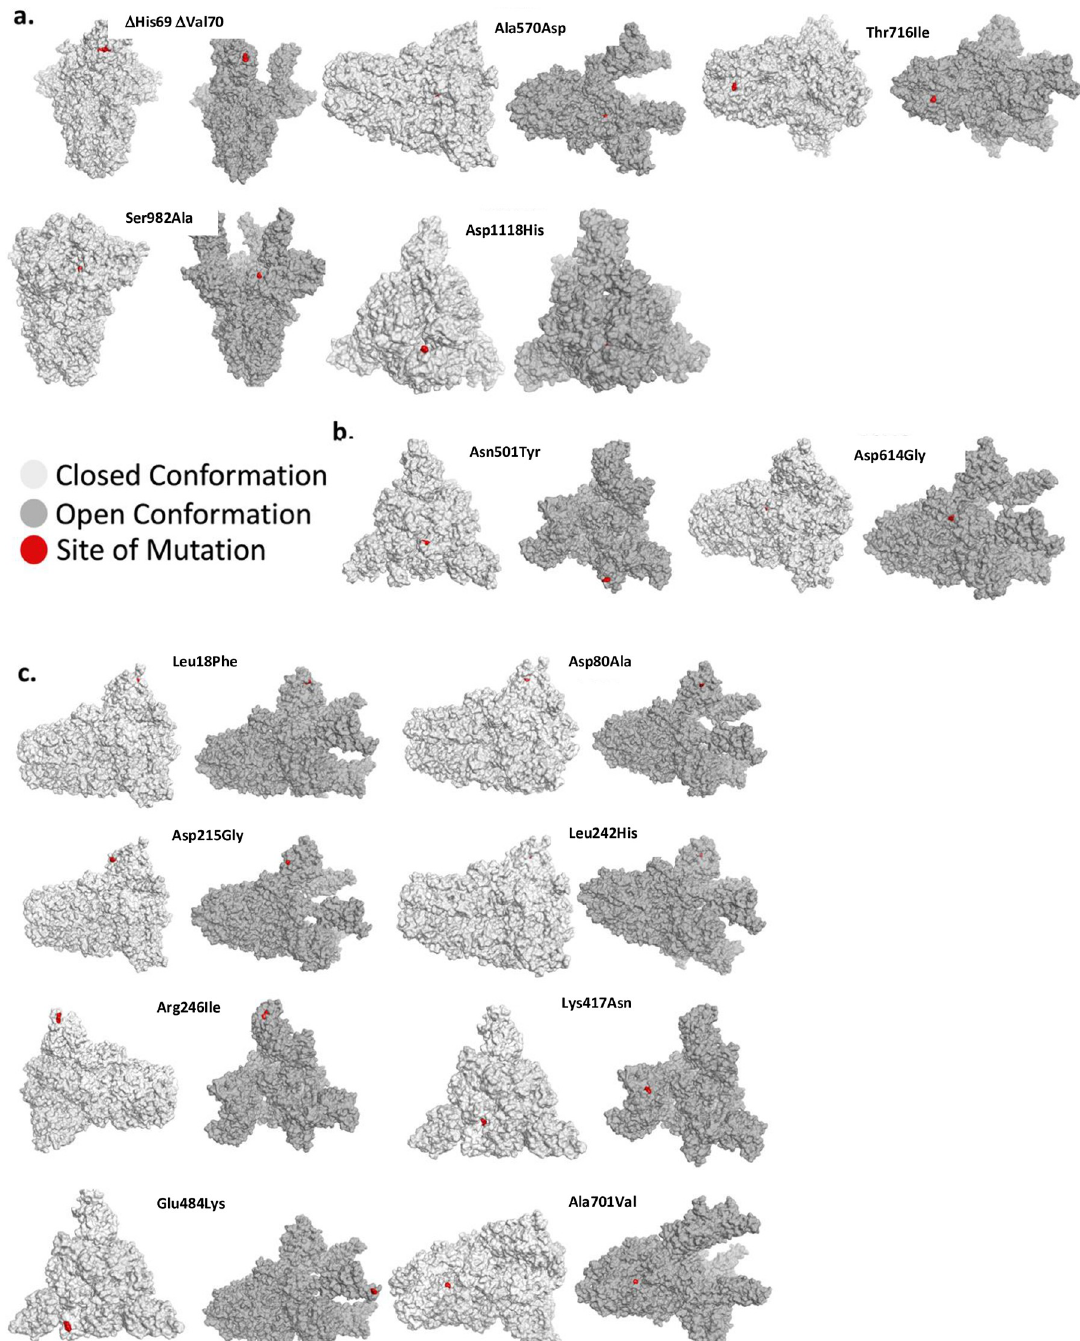
Fig 1. Mutant position in the open and closed conformation of the spike protein. (a) The position of various mutations of the Y501. V1, (b) The Asn501Tyr and Asp614Gly mutations, which occur in both the Y501.V1 and Y501.V2 variants, and (c) Mutations unique for the 501Y.V2. Each mutation is shown in red in one of the monomers in the 3D structure of the spike protein trimer. Shown is the closed conformation (light gray) and the open (dark gray) conformation.